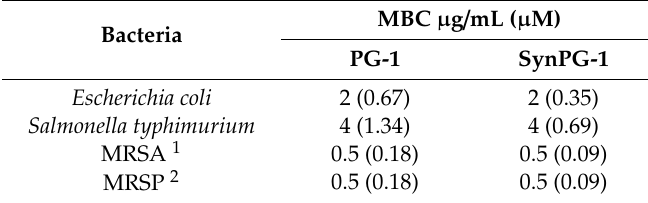
Table 2. The minimal bactericidal concentration (MBC) of peptides against planktonic bacterial cells. Bacteria